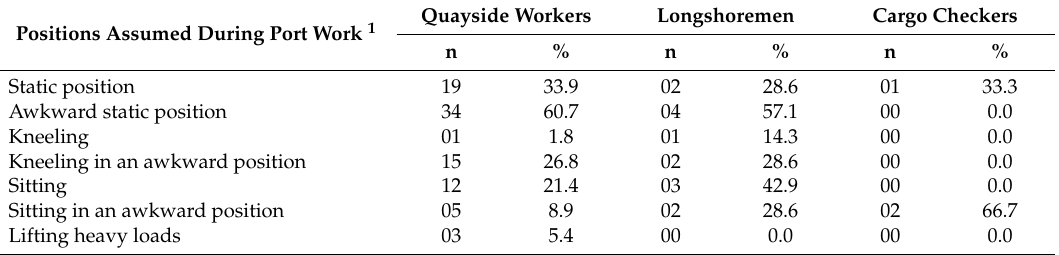
Table 7. Frequency of observation concerning body positions of dockworkers during work. Positions Assumed During Port Work